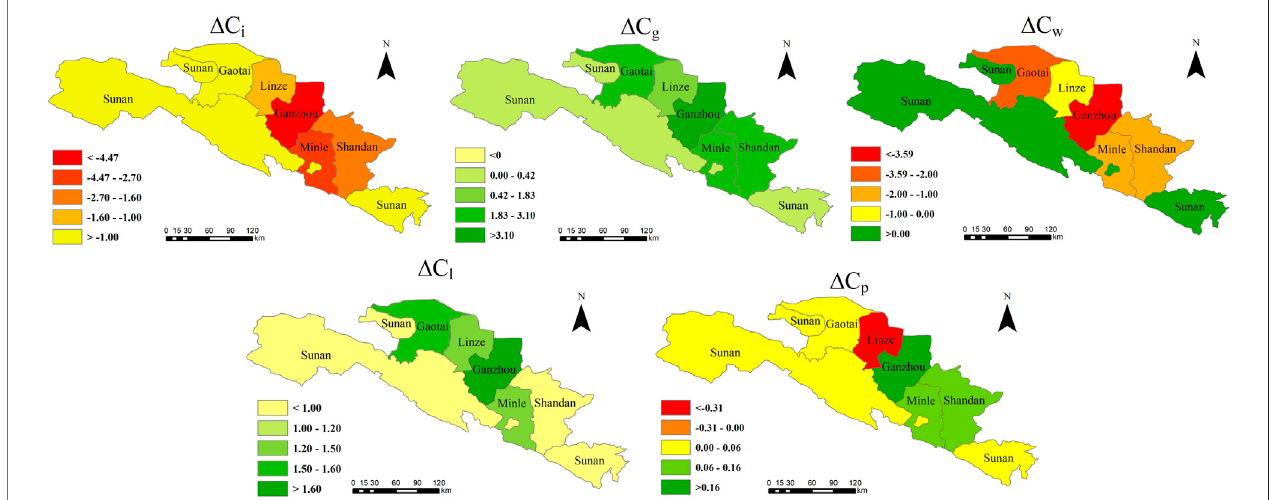
FIGURE 7 | Spatial distribution of the contribution values of agricultural carbon emission in fl uencing factors in Zhangye during 2012 – 2019.